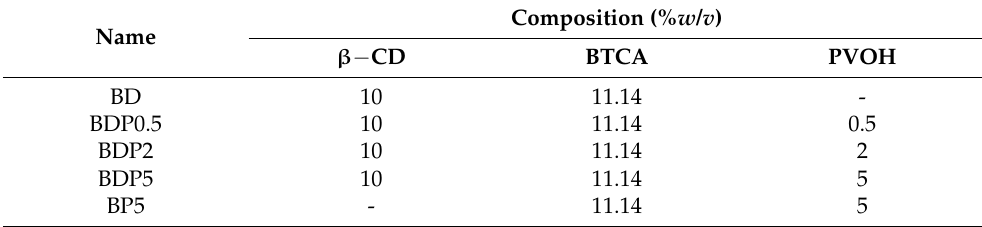
Table 1. Different formulations for cotton cord